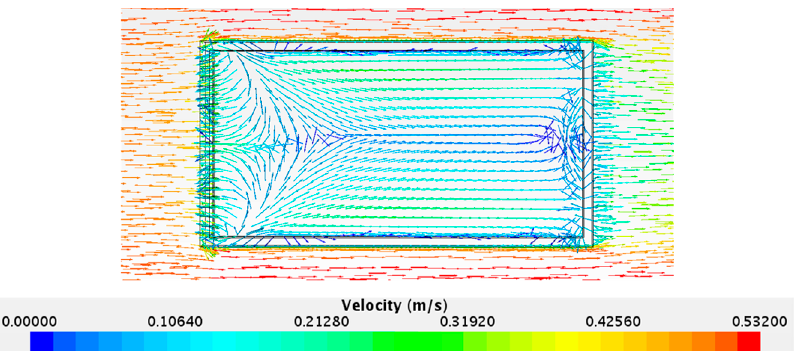
Figure 7. Velocity distribution of module bottom (the case without cooling).